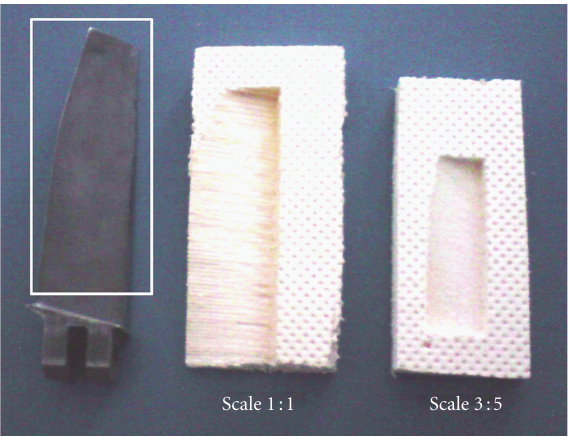
Figure 16: Reproduction of the first test specimen: axial compressor blade.